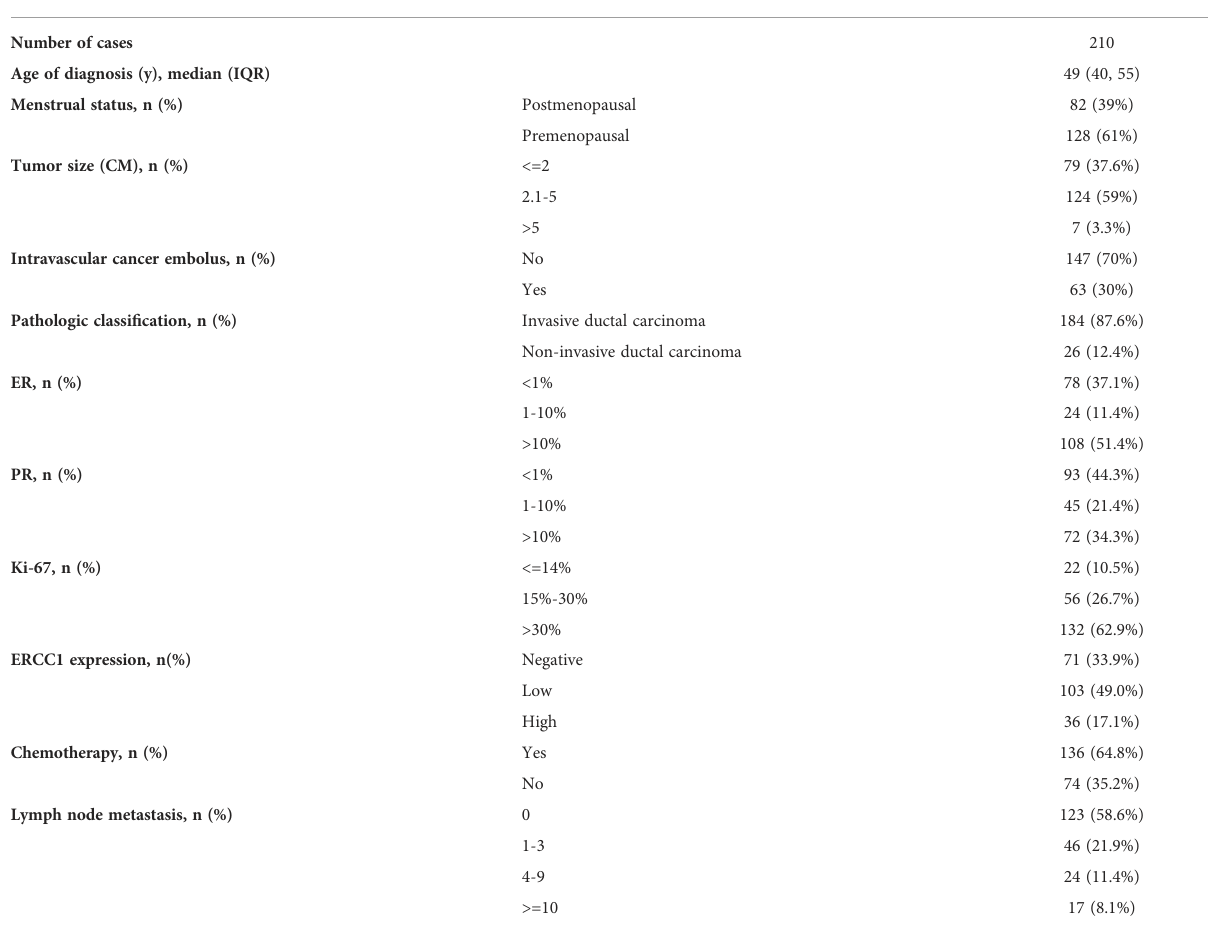
TABLE 1 clinical baseline characteristics of 210